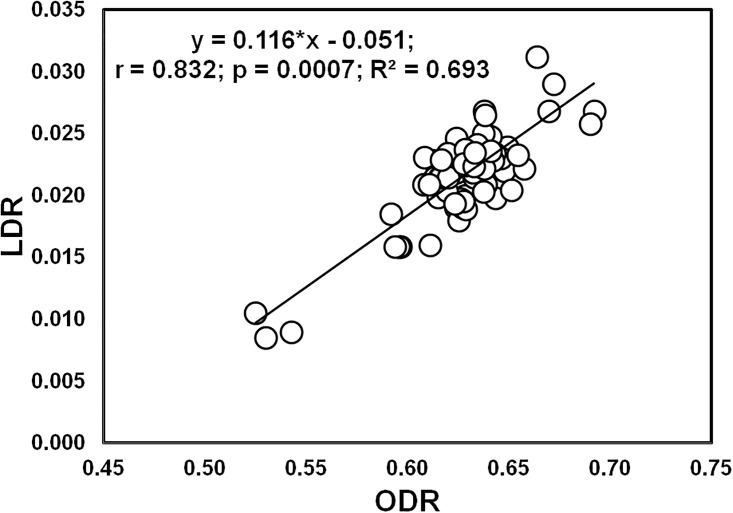
Relationship between LDR and ODR of corn oil.